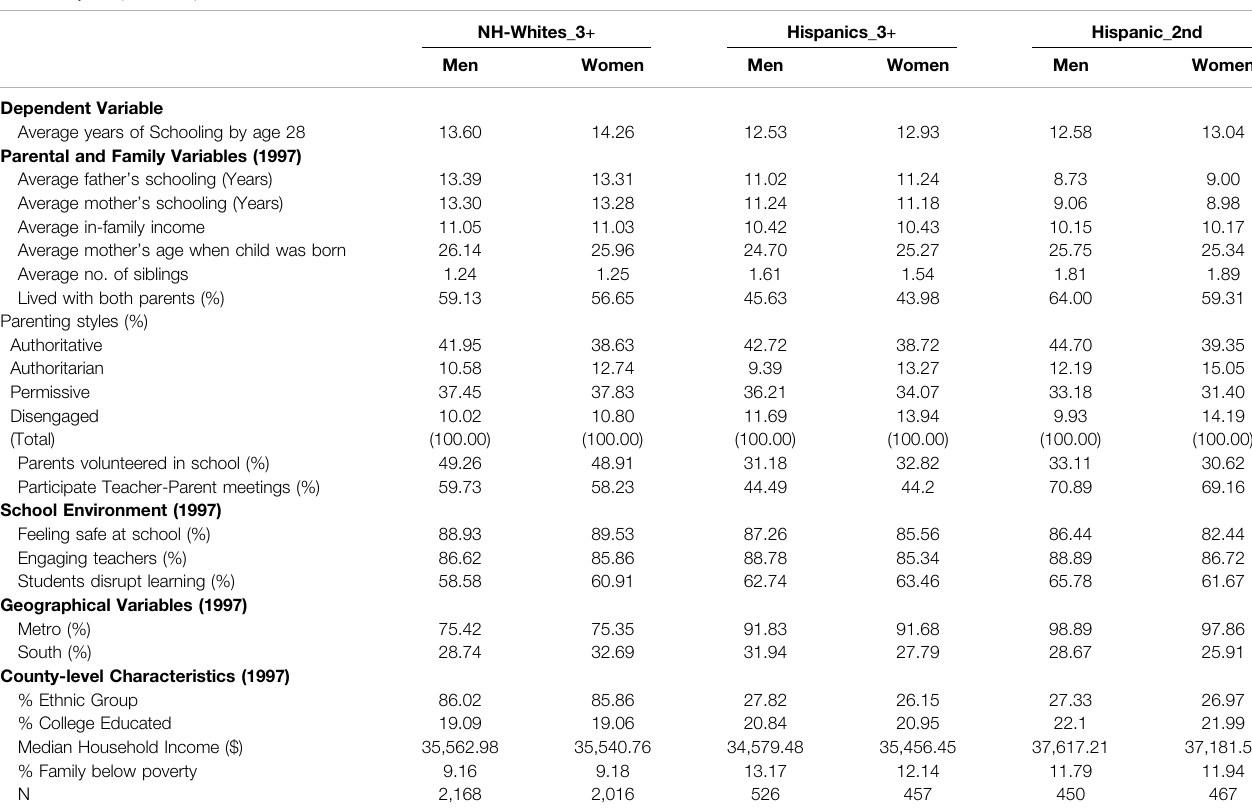
TABLE 1 | Sample descriptive statistics.